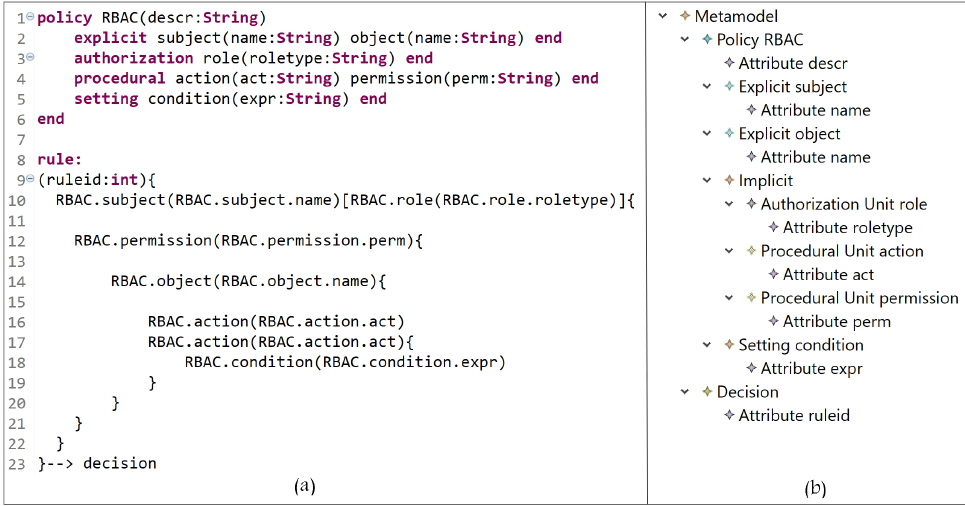
Figure 11. ( a ) RBAC policy definition; ( b ) RBAC